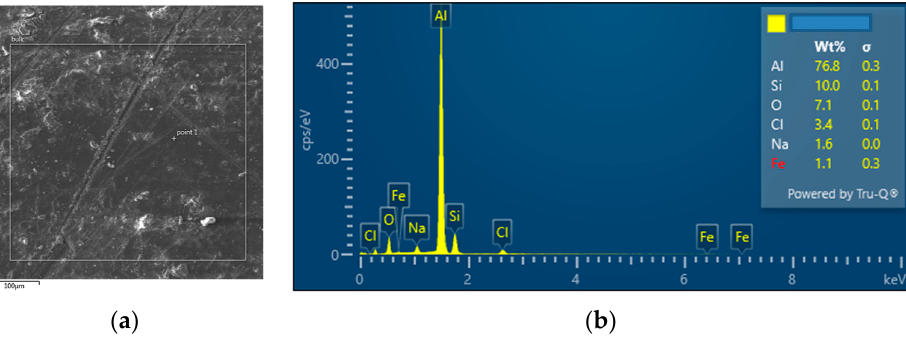
Figure 14. EDX analysis and its evaluation with respect to the local chemical composition: ( a ) chemical composition of the AlSi12 alloy used; ( b ) sample SAM4.